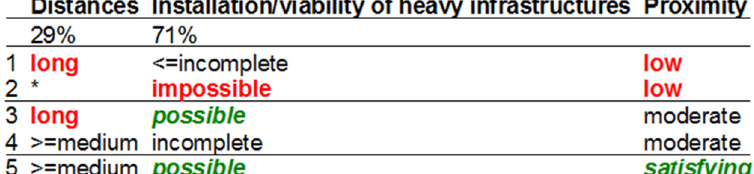
Figure A1. Utility function of the aggregated attribute Proximity.